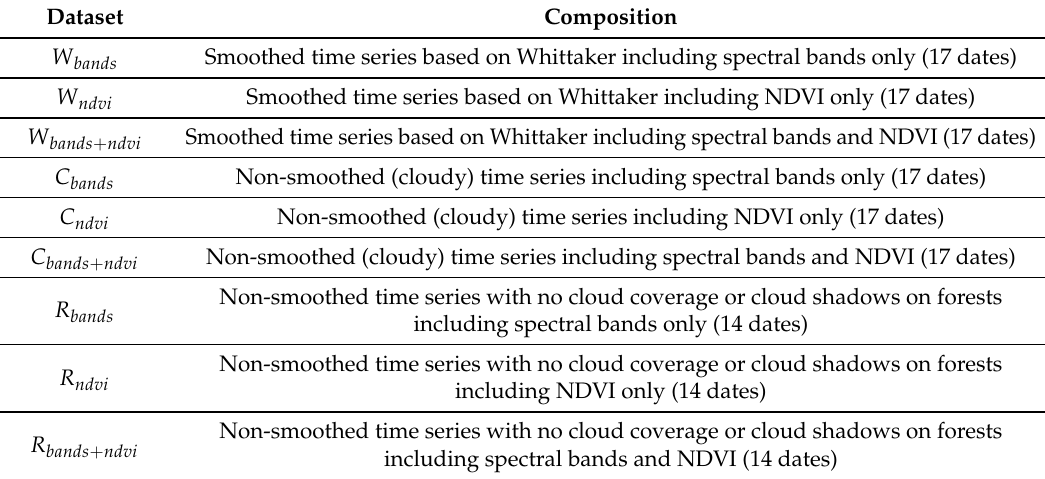
Table 2. Datasets used to evaluate the influence of the spectral features and the smoothing on the classification